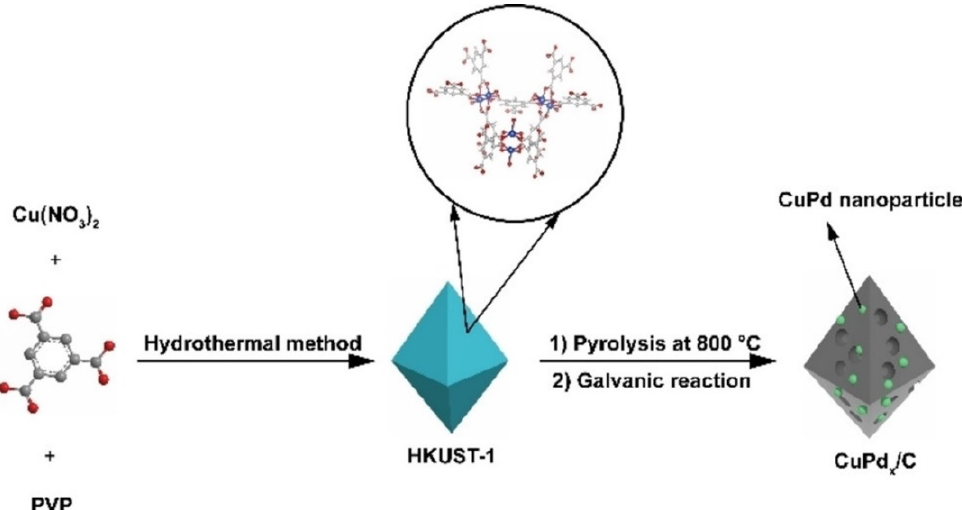
Figure 8. Schematic illustration of the method for the synthesis of CuPd x . Reproduced with permis- sion from ref [126]. Copyright 2022 Wiley-VCH.